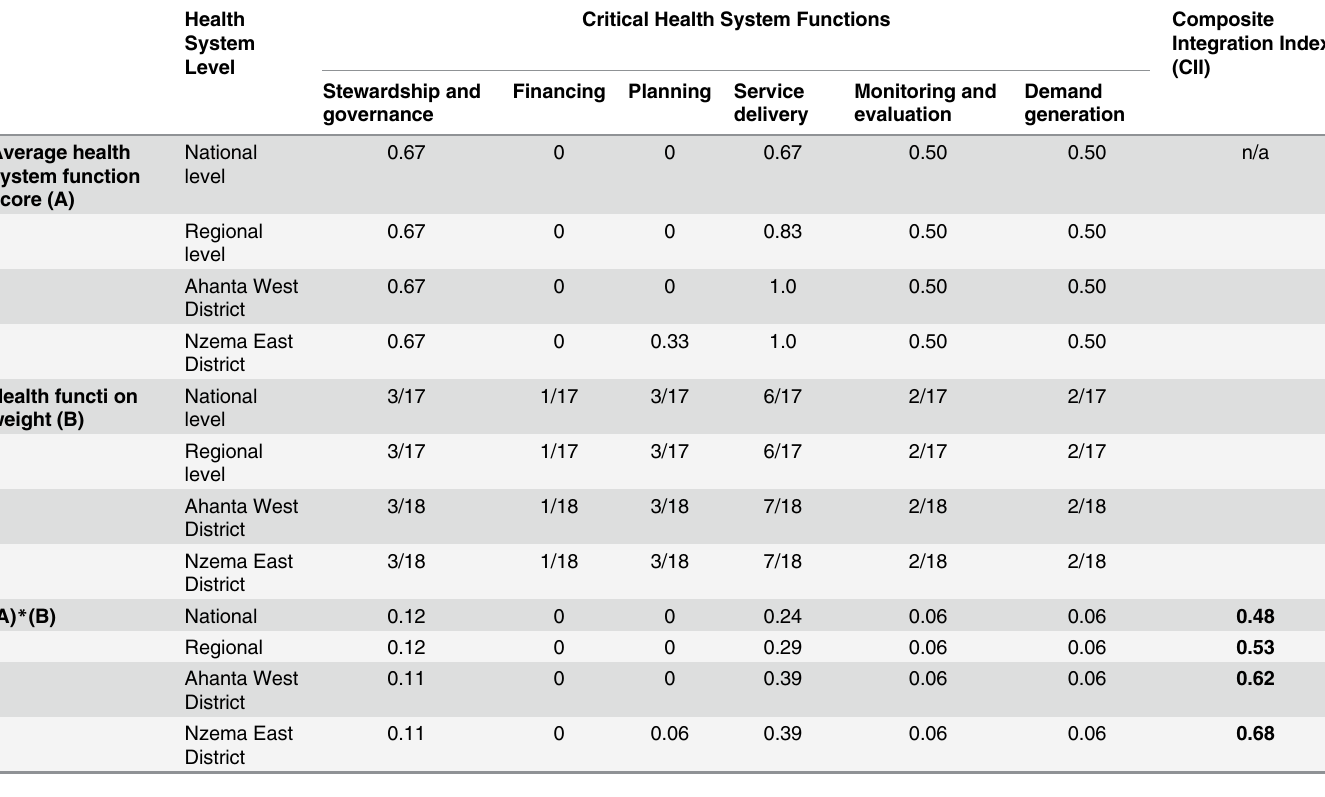
Table 5. Estimation of Composite Integration